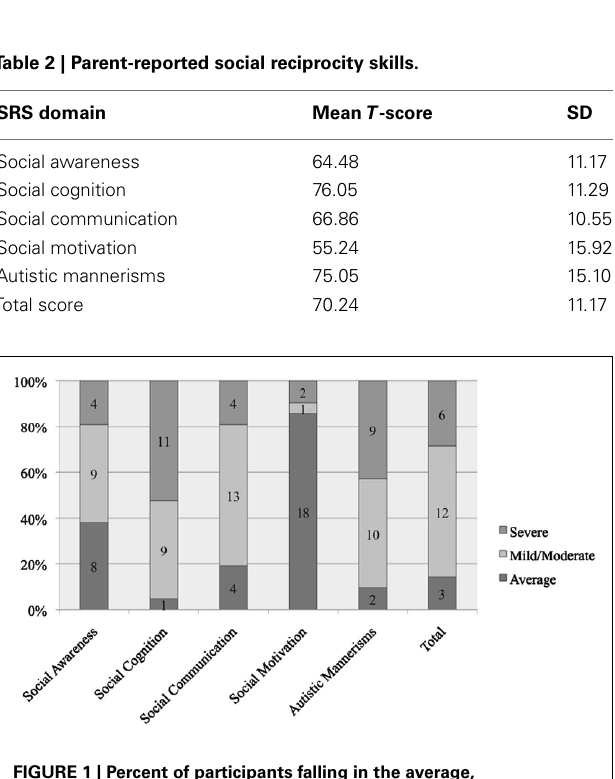
FIGURE 1 | Percent of participants falling in the average, mild/moderate, and severe ranges on the social responsiveness scale parent report measure (number of participants